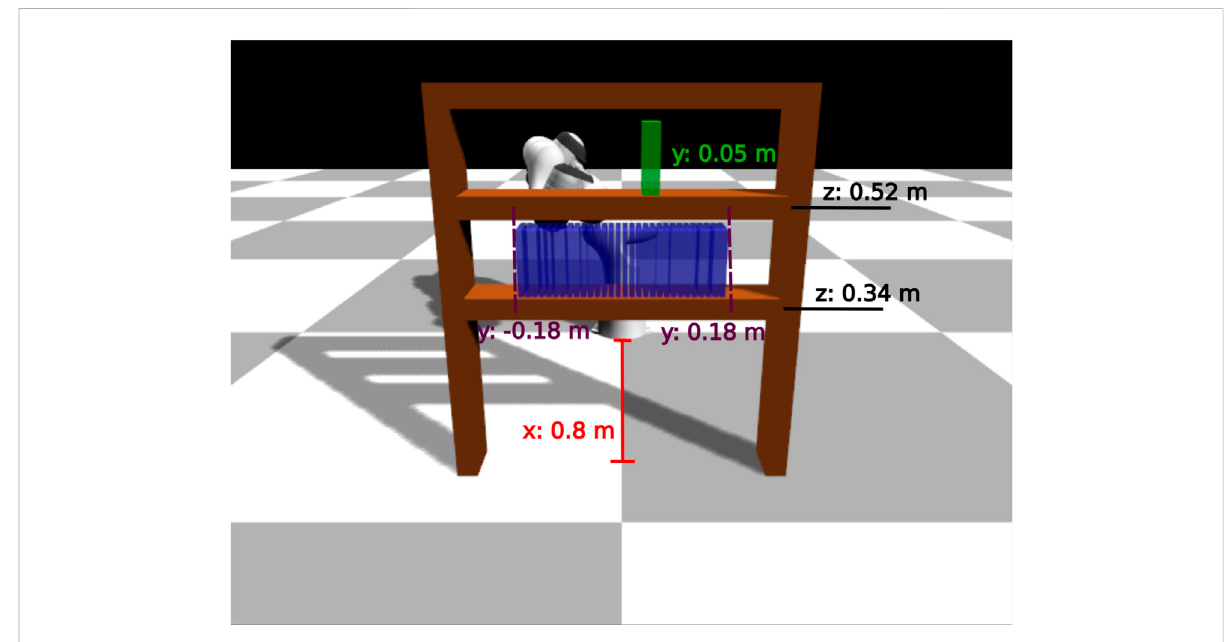
FIGURE 8 Bookcase task: evaluation con fi gurations. We use 30 different initial book positions (denoted with blue color).